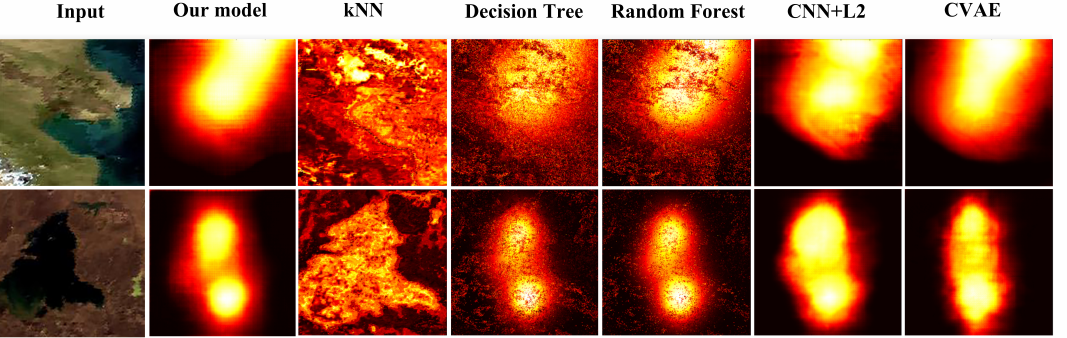
Figure 8. We compared the performance of our model and baselines on two test samples. We colorized the original probability map with the hot colormap which represents the probability value from low-to-high using dark-to-bright colors.